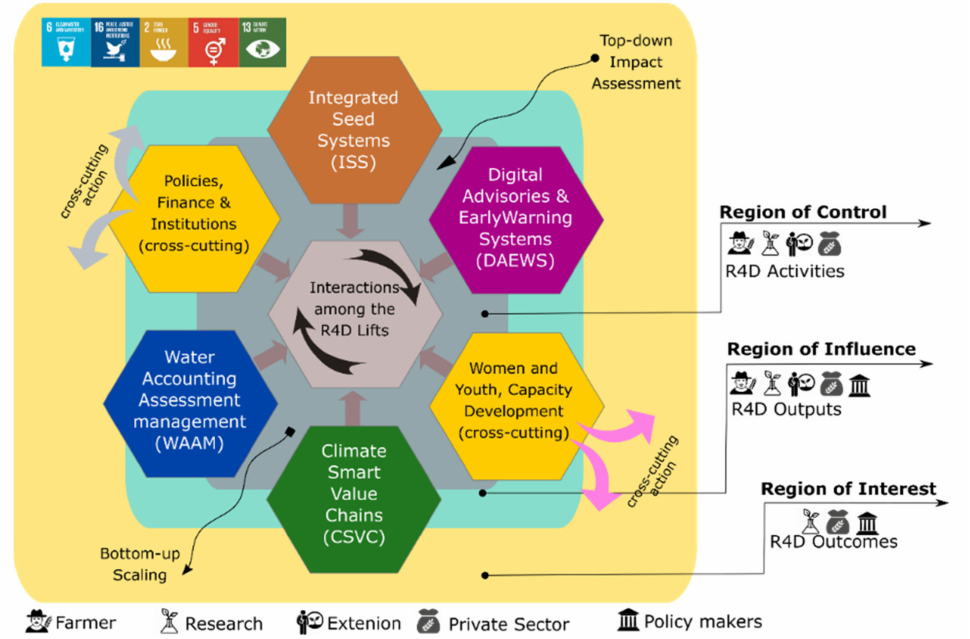
Figure 2. Theory of change diagram of the MENA Grand Challenge research vision, in which six R4D thematic actions (4 transversals and 2 cross-cutting) operating synergistically across the scales across the three regions (activities, outputs and outcomes) culminating in impact. The arrows depict “bottom-up” scaling efforts and “top-down” impact analysis. The region of interest (outcomes) addresses 13